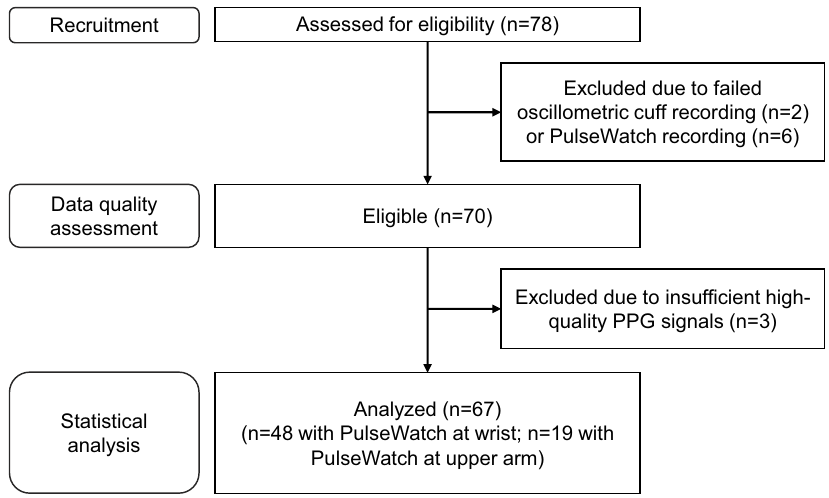
Figure 1. Flow diagram of the study, from participant recruitment to statistical analysis.